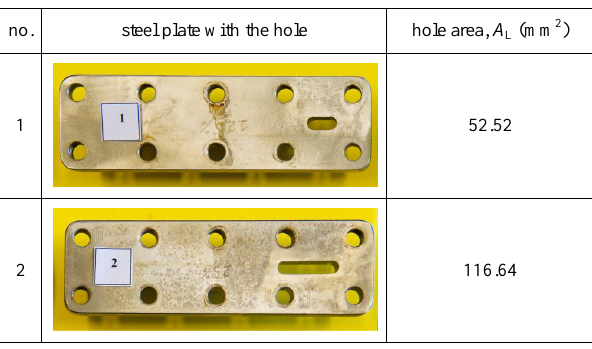
Table 1. Geometrical characteristics of leaks used in tests.